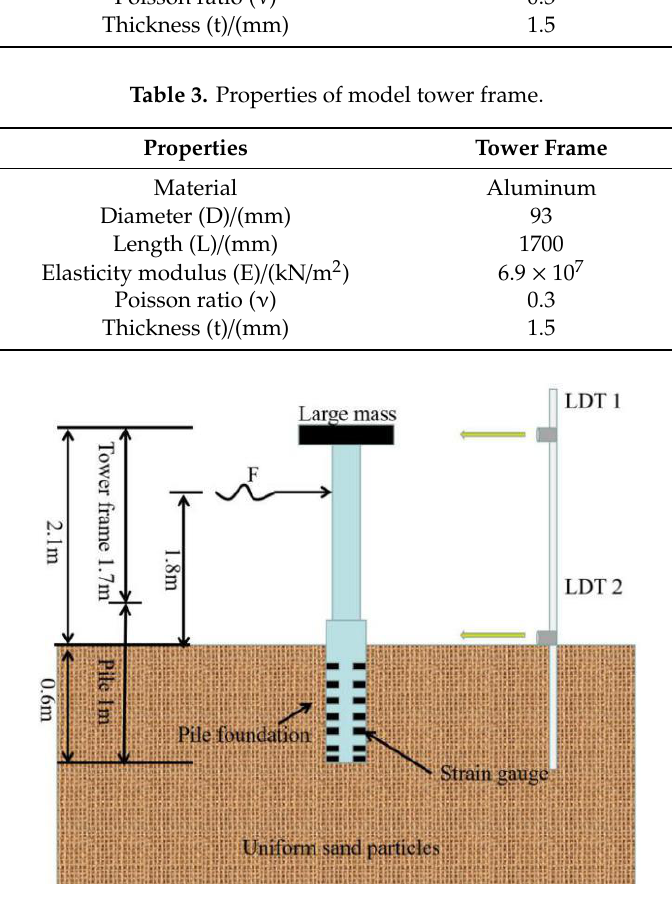
Figure 2. The actual whole structure of wind power foundation. Notes: LDT, a laser displacement transducer; Laser 1 or 2, Laser displacement sensor.